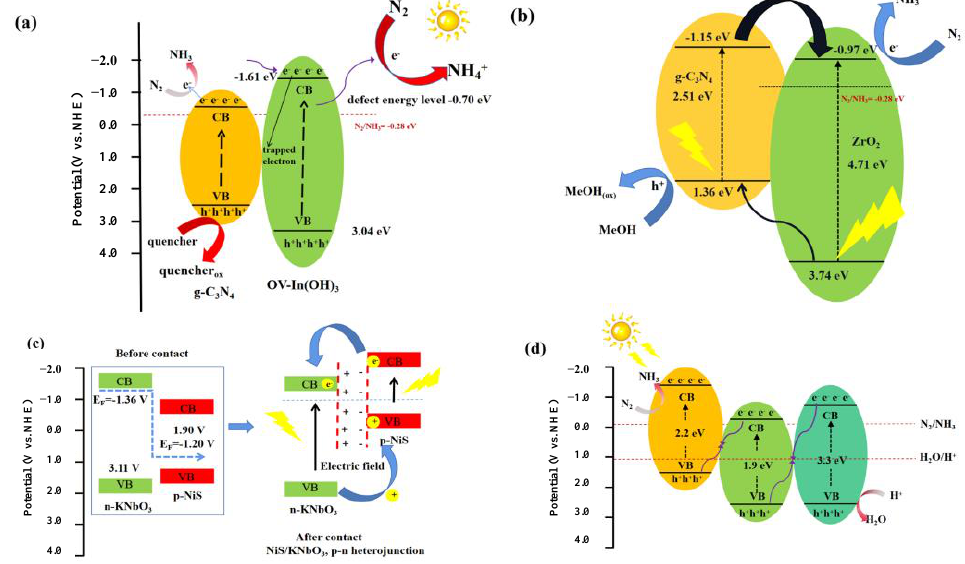
Figure 4. Schematic illustrations of photocatalytic N 2 fixation over ( a ) OV-In(OH) 3 /g–C 3 N 4 , ( b ) g–C 3 N 4 /ZrO 2 , ( c ) NiS/KNbO 3 , ( d ) Cu 2 O/MoS 2 /ZnO−cm.